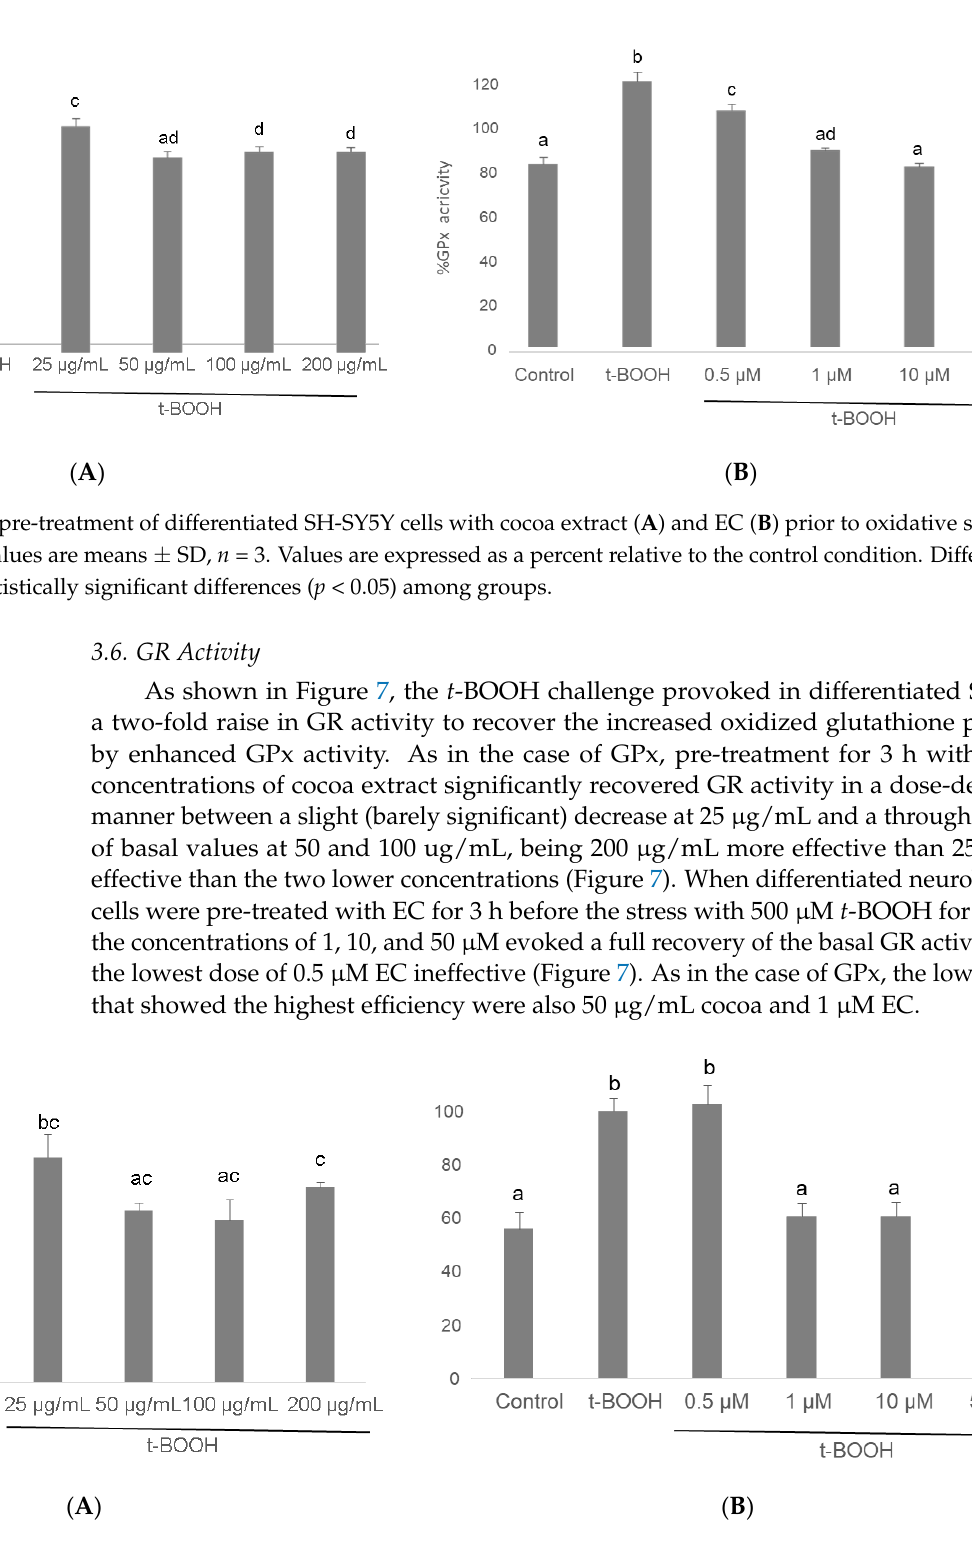
Figure 7. Effect of pre-treatment of differentiated SH-SY5Y cells with cocoa extract ( A ) and EC ( B ) prior to oxidative stress on GR activity. Values are means ± SD, n = 3. Values are expressed as a percent relative to the control condition. Different letters indicate statistically significant differences ( p < 0.05) among groups.